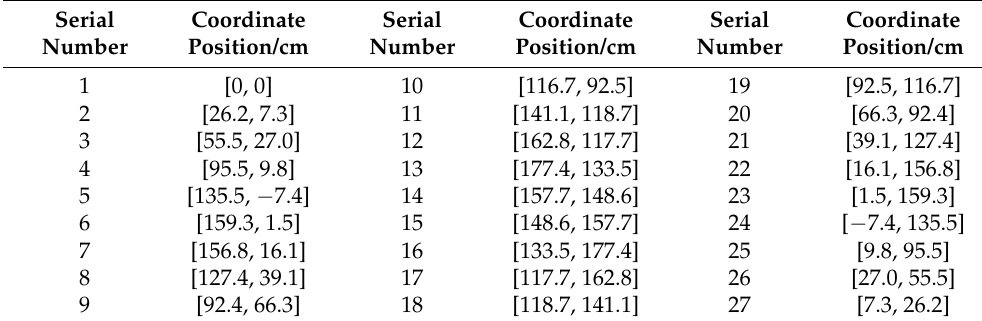
( b ) Figure 29. ( a ) Single frame and ( b ) 100 cycles echo diagrams with SNR of 12 dB in narrowband.